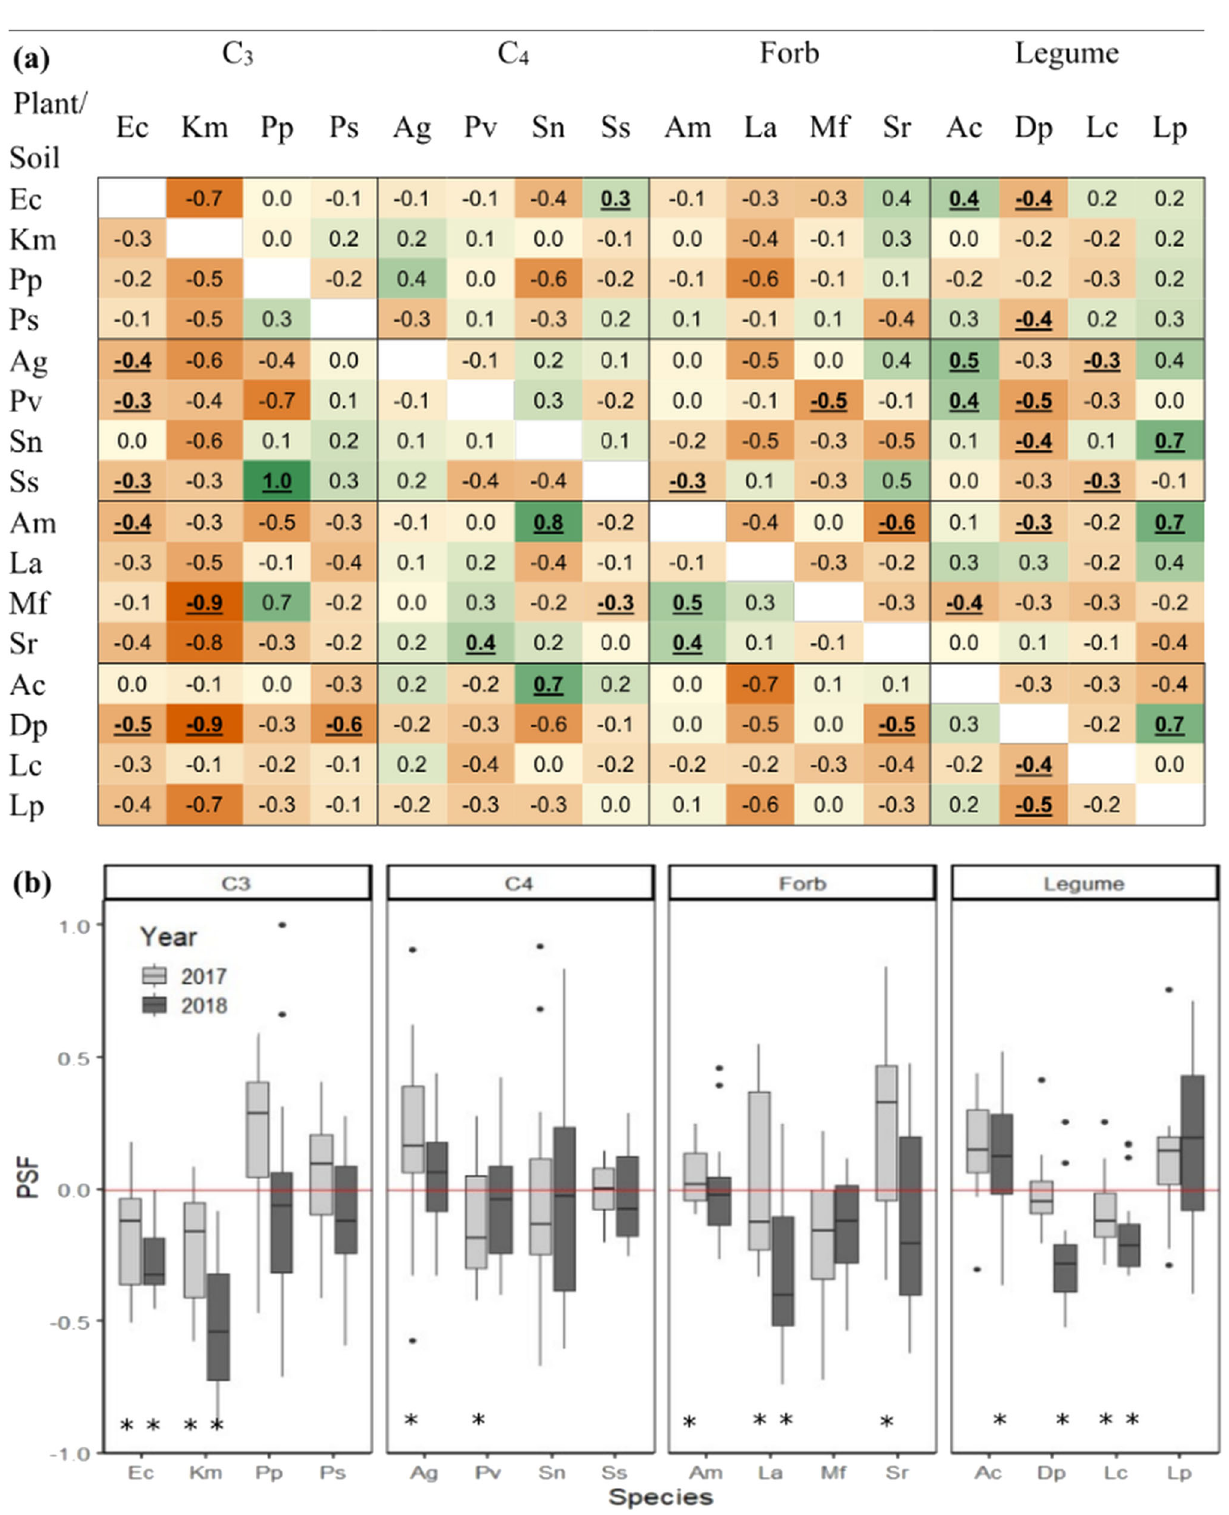
Fig. 1 Plant-soil feedbacks (PSF) for 16 plant species. PSF values from 2018 for each plant, on each soil-cultivation type shown in panel a . Orange and green highlighted values indicate negative and positive PSFs, respectively, and values with con fi dence intervals that do not overlap zero are bolded and underlined. Sample sizes derived from 27 – 35 replicates on ‘ self ’ soils and 5 – 9 replicates on each ‘ other ’ soil for each species. Exact sample sizes reported in Supplementary Table 1. Averaging across the 15 soil-cultivation type PSFs, produced one ‘ species-level ’ PSF value for each plant species ( b ). These species- level PSF values are shown for data from 2017 (grey) and 2018 (black). Each value represents the mean and standard error associated with the 15 soil- cultivation-speci fi c PSF values. Asterisks indicate values that differed from zero in a one-sample t -test at ( α = 0.05).